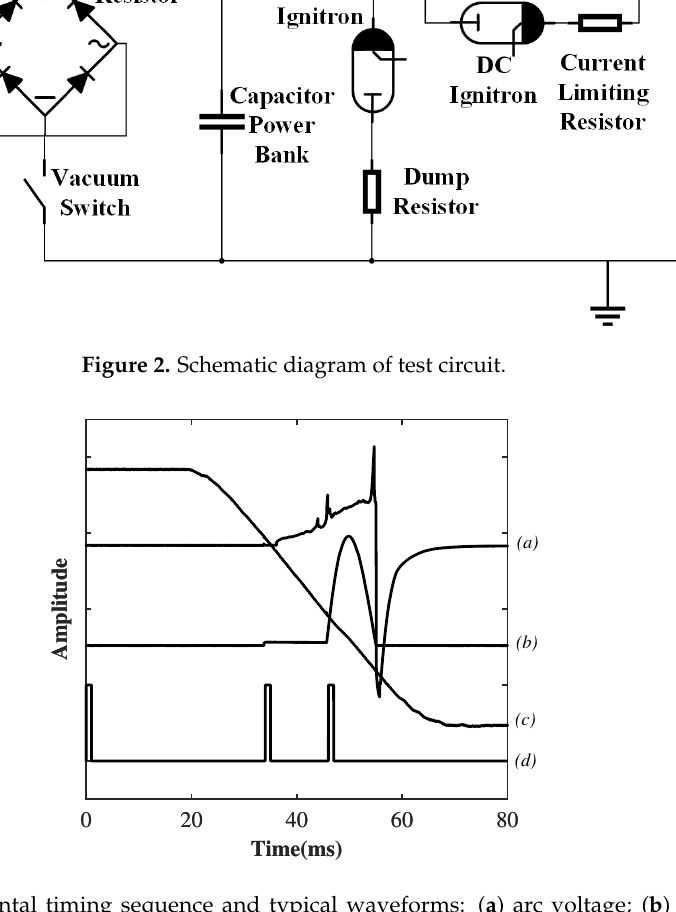
Figure 3. Experimental timing sequence and typical waveforms: ( a ) arc voltage; ( b ) arc current; ( c ) contact separation; and ( d ) trigger